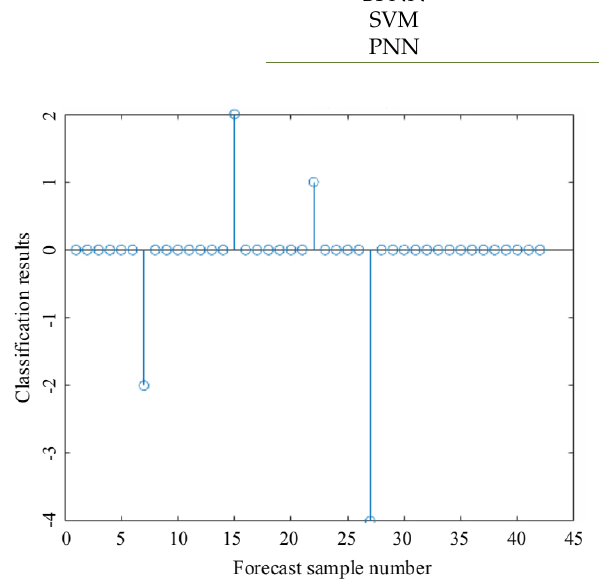
Fig. 10. Test error diagram of fault diagnosis system